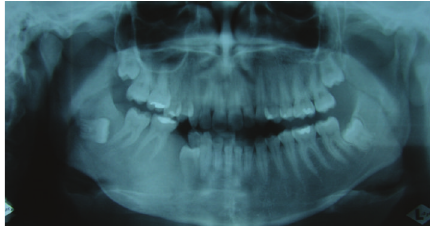
Figure 1: Panoramic X-ray (2005) showing alteration in the cancel- lous bone of the right hemimandible. Figure 2: Panoramic X-ray (2009) showing radioopaque area